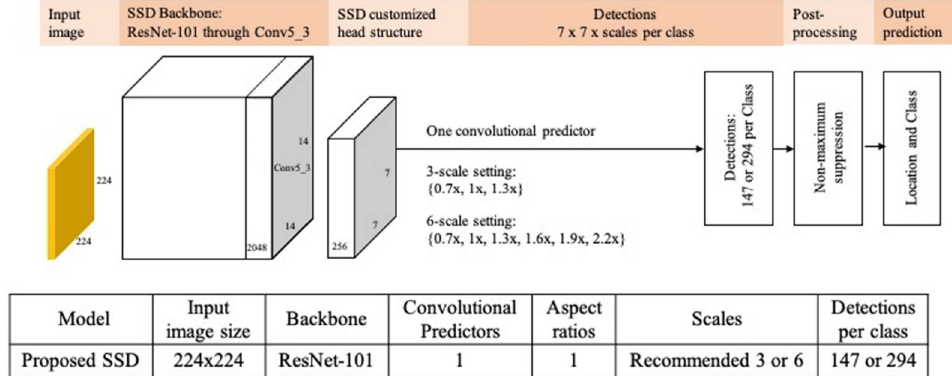
Figure 2. Comparison of SSD model architectures. Proposed architecture with ResNet-101 backbone and other customized settings.